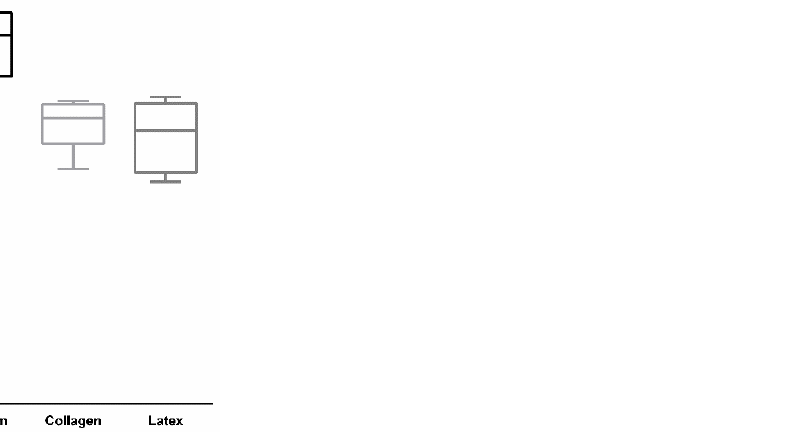
Figure 6. Percentage of engorged Culex quinquefasciatus females after artificial blood feeding on different membranes (bars = ± SEM).